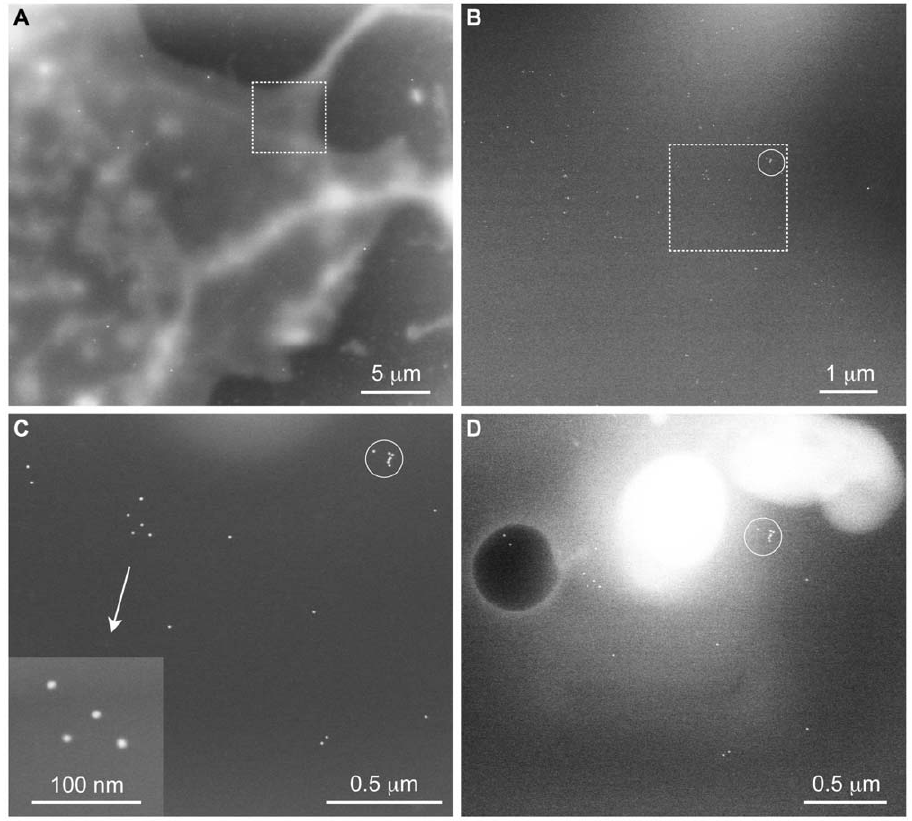
Figure 6. Wet STEM imaging of gold-labeled (10 nm diameter) epidermal growth factor receptors in COS7 cells. (A) Image of a part of a cell, showing the cell in lighter grey tones against a darker, uniform background. At this magnification only clusters of gold labels are visible. (B) Image recorded at the position of the dashed rectangle in (A) at a higher magnification where labels become visible. (C) The gold labels are visible as individual particles. The inset shows the labels at the highest magnification in this imaging series. (D) Two types of beam damage occurred after the imaging series. A dark round shape is visible at the left and white shapes are visible at the top.